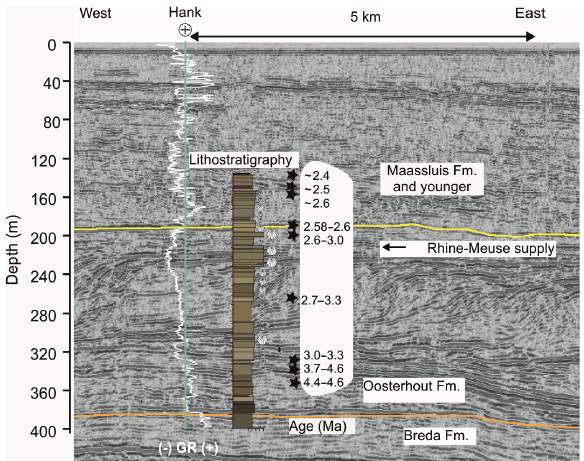
Figure 3. Seismic east to west depth profile at the Meuse River (from Maas2002 survey, https://www.nlog.nl, last access: 10 Febru- ary 2019) with the location of the Hank borehole (B44E0146) and corresponding formations indicated. The smoothed gamma ray log (from https://www.dinoloket.nl, last access: 15 April 2019; white) and lithology of the borehole are provided for context. Stars and age ranges refer to the biostratigraphic age model of Dearing Crampton- Flood et al. (2018). The orange and yellow lines represent the boundaries of the Breda and Oosterhout (revised) and the Ooster- hout and Maassluis formations,